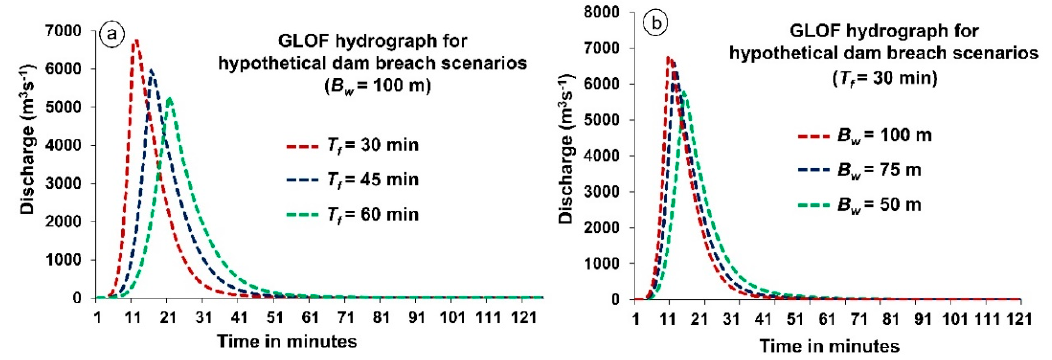
Figure 8. Breach hydrographs obtained for varied ( a ) time of moraine-failure ( T f ) keeping breach width ( B w ) constant; and ( b ) breach width ( B w ) keeping the time of moraine-failure ( T f ) constant. Table 3. Hydraulic properties of potential GLOF along the flow channel for varied moraine-failure time.